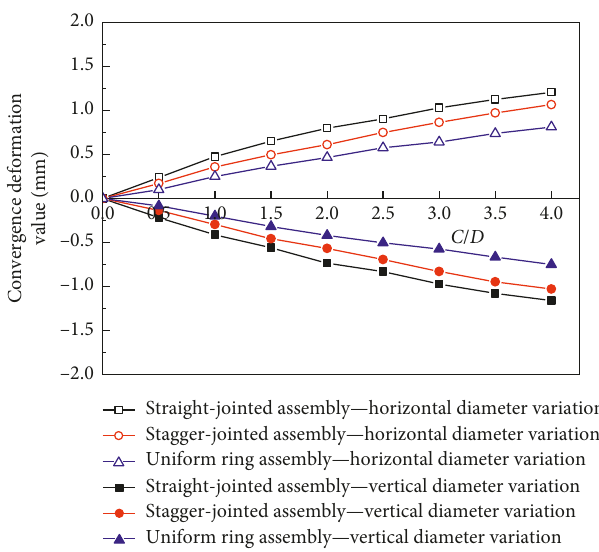
Figure 14: Variations in the average diameters of the three re- peated tests for each assembly mode under the realistic loading conditions.